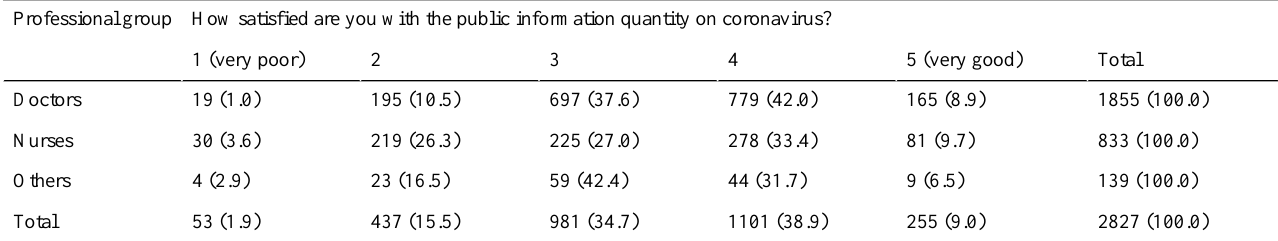
How satisfied are you with the public information quantity on coronavirus?Professional group